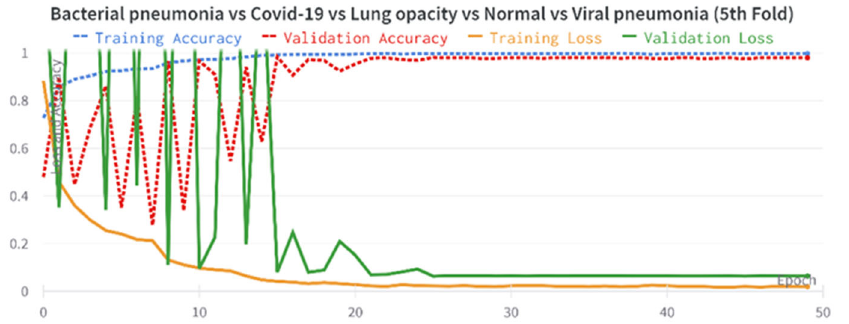
Figure 4. Accuracy and loss plots over 50 training epochs for 5-class experiments (5th fold).